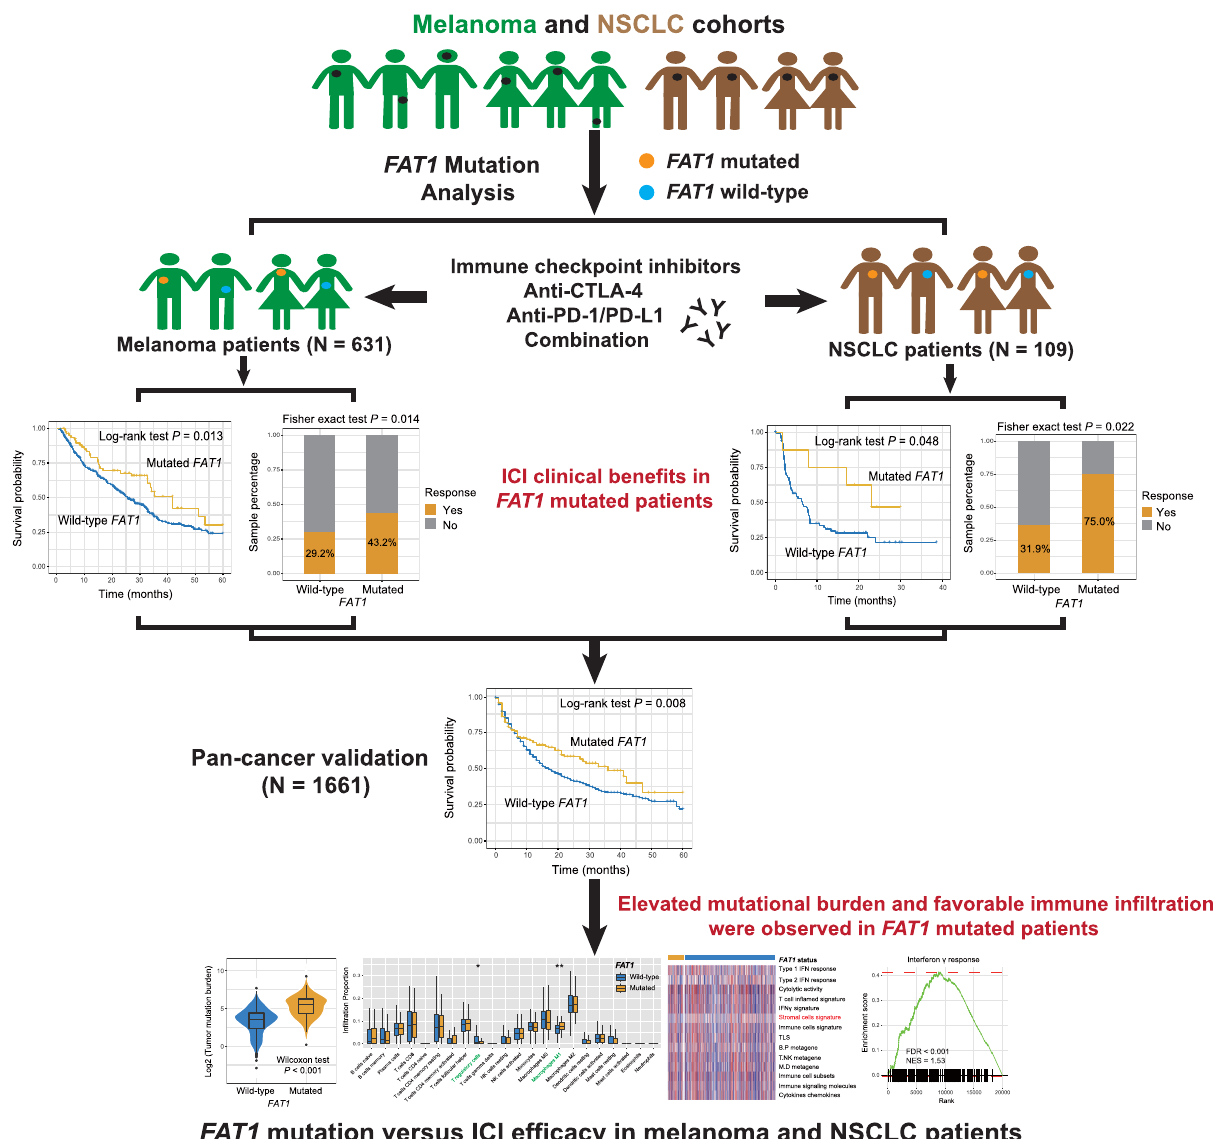
Fig. 1 Detailed work fl ow of this study. FAT1 mutations versus ICI ef fi cacy in melanoma and NSCLC patients. Green samples, melanoma; brown samples, NSCLC; orange dot, mutated FAT1 ; blue dot, wild-type FAT1 .